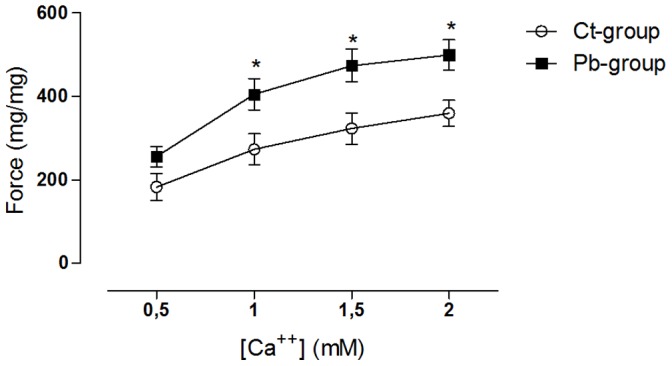
Concentration-response curve for increasing extracellular [Ca++] in isolated left ventricular papillary muscles from control and lead-treated rats.Symbols represent mean ± SEM. Open circles- controls (N = 9), filled squares- lead treated group (N = 10). *p<0.05, Ct-group vs. Pb-group, two-way repeated measures ANOVA, followed by Bonferroni’s test.